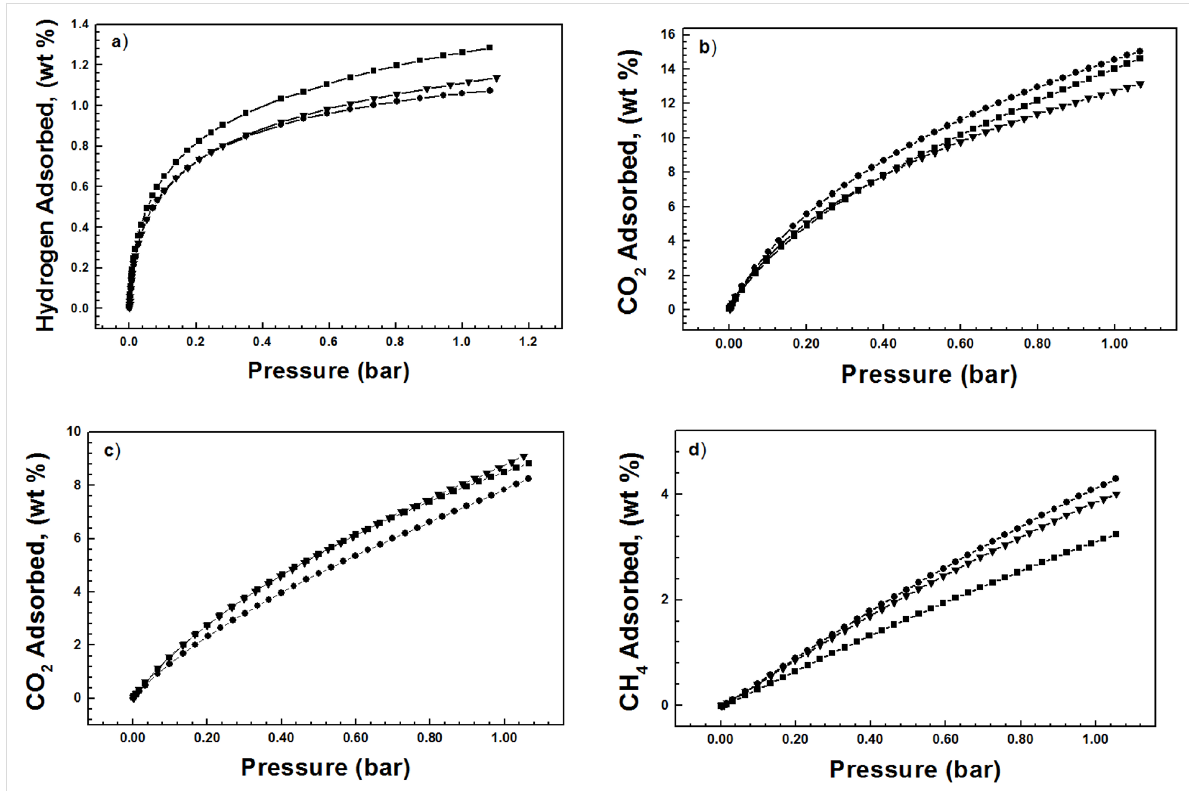
Figure 4: Gravimetric gas adsorption isotherms for PPOP-1 (downtriangle), PPOP-2 (circle), and PPOP-3 (square) (a) hydrogen at 77 K, (b) carbon dioxide at 273 K, (c) carbon dioxide at 298 K, and (d) methane at 273 K.